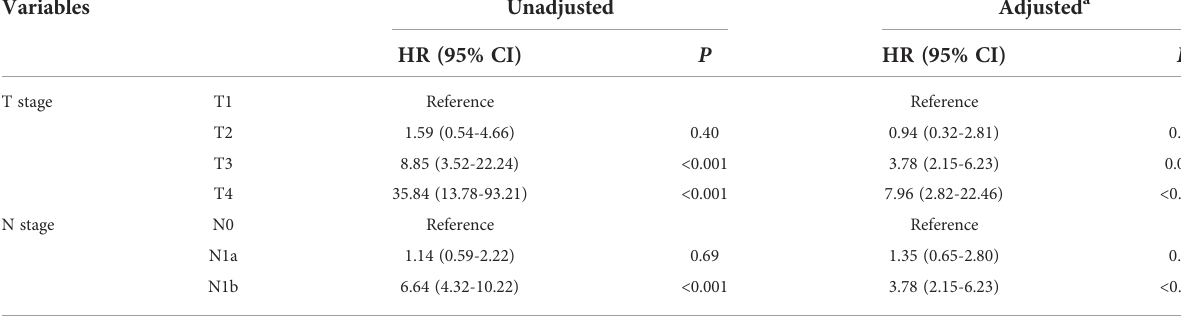
TABLE 2 T classi fi cation and N classi fi cation impact on 10-year cancer-speci fi c